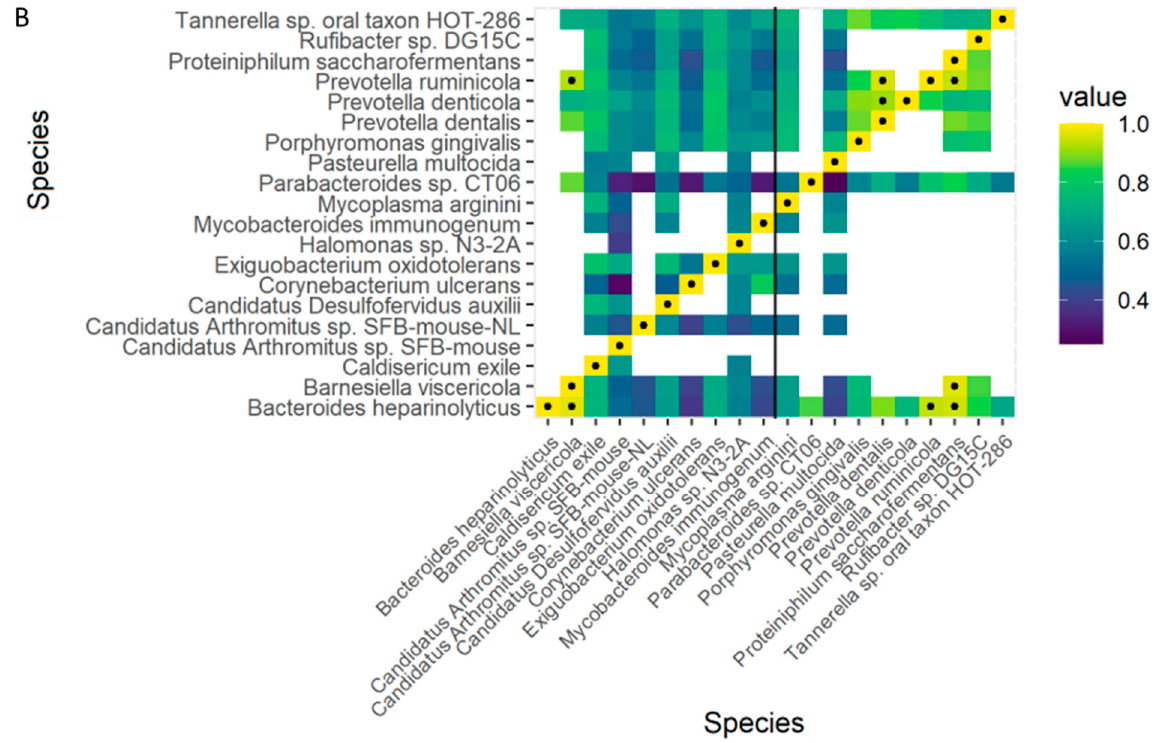
Figure 7. Correlation of the distribution of OC-affected mouse GM species and known human levels at various anatomical locations, as per the Human Microbiome Project (HMP) database. ( A ) Distribution of GM bacteria species most-affected by OC treatment (our experiments) in different human body locations, using a tool for comparison to HMP data. Prevalence (presence/absence) as well as mean abundances were calculated for the taxa with stratification by body location. Our data were compared against data from the HMP, which contains 690 samples collected from different human body sites and that passed quality control, each sample consisting of many varieties of bacteria. The analysis was obtained for the bacterial species most significantly impacted by OC in our experiments ( p -value ≤ 0.1, vide supra). ( B ) Comparison by Spearman's correlation for the OC-affected bacteria to the five taxa in the HMP database selected using z -score normalized abundances to validate similarities. Correlation coefficients with an absolute value > 0.9 are labeled with a black dot.